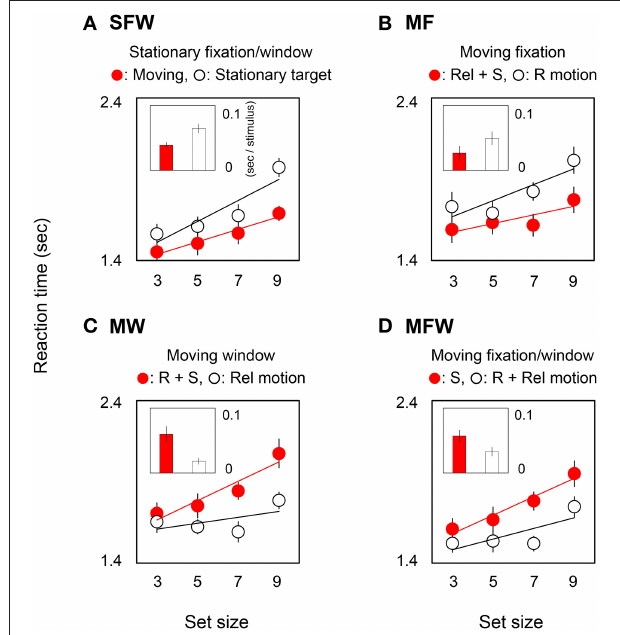
FIGURE 2 | Reaction times and slope values in target-present searches. Each graph corresponds to the results for the four ( A : SFW, B : MF, C : MW, D : MFW) conditions averaged across seven observers. Representative response times in the target presence/absence task (and a linear interpolation) are plotted as a function of set-size of grating stimuli. Each bar shows a slope value indicating search efficiency (sec/stimulus). Red and white plots show results for MOVING and STATIONARY targets respectively and include different combinations of motion signals across retinal (R), relative (Rel), and spatiotopic (S) coordinate systems. Error bars represent 1 ±